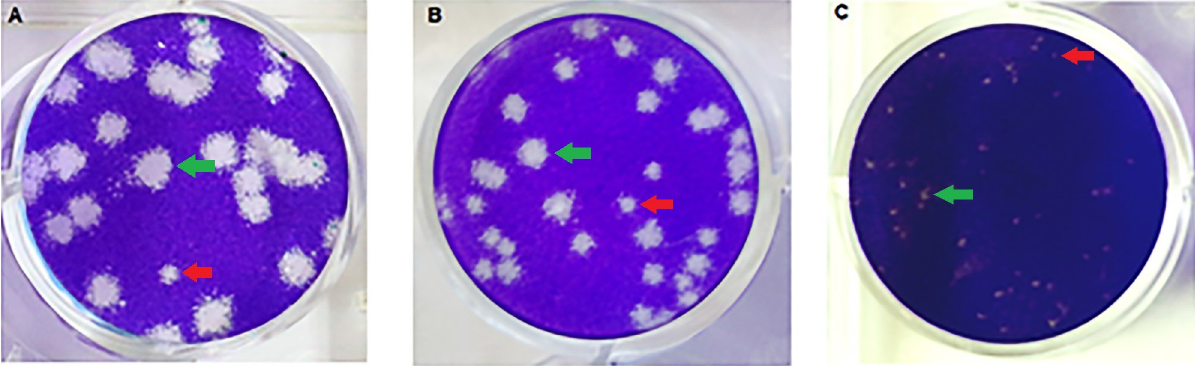
Fig 1. The difference in plaque sizes and mixed population (the bigger plaque shown by green arrow and smaller plaque shown by red arrow) of ZIKV isolates; (A) MUMT-1/2016 (2.37–4.40 mm.), (B) MU-DMSC-1/2017 (0.90–3.90 mm.) and (C) MU-DMSC-6/2016 (0.17–2.24 mm).